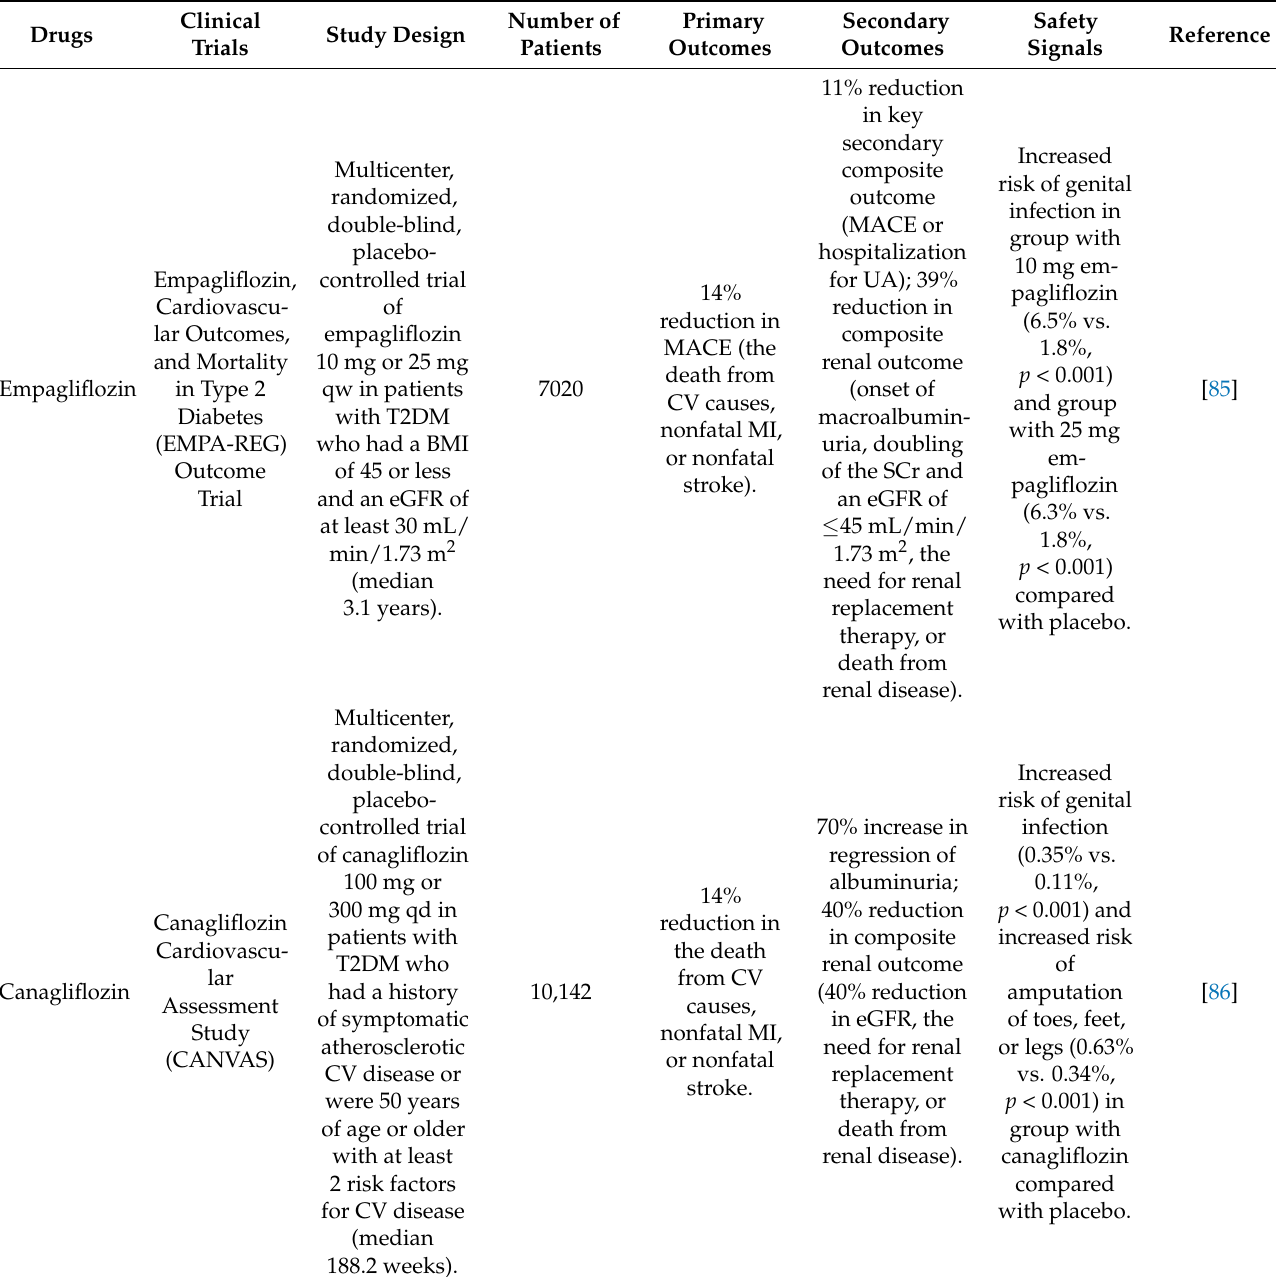
Table 2. Major clinical studies related to SGLT2